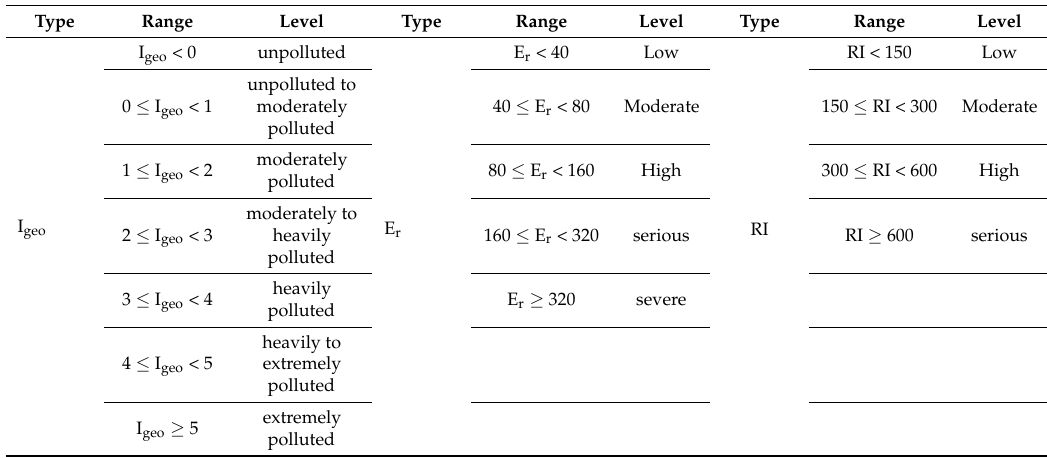
Table 1. Classification of I geo and